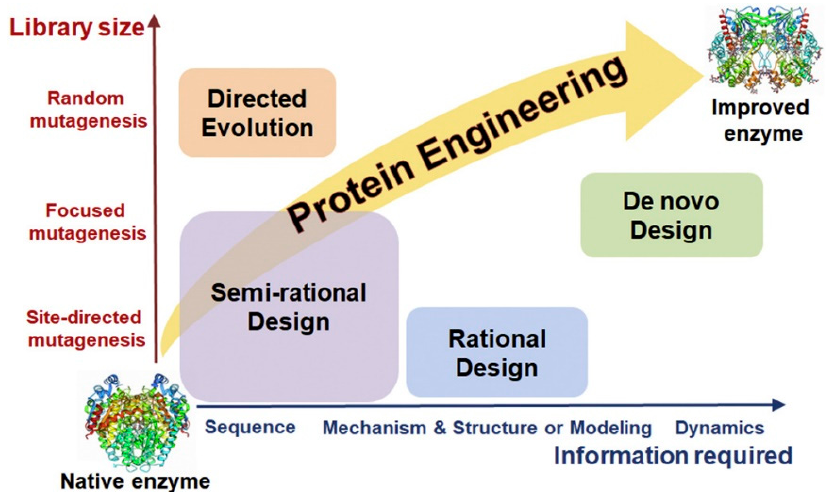
Figure 5. Protein engineering methods to improve enzyme stability. Reprinted with permission from [87].